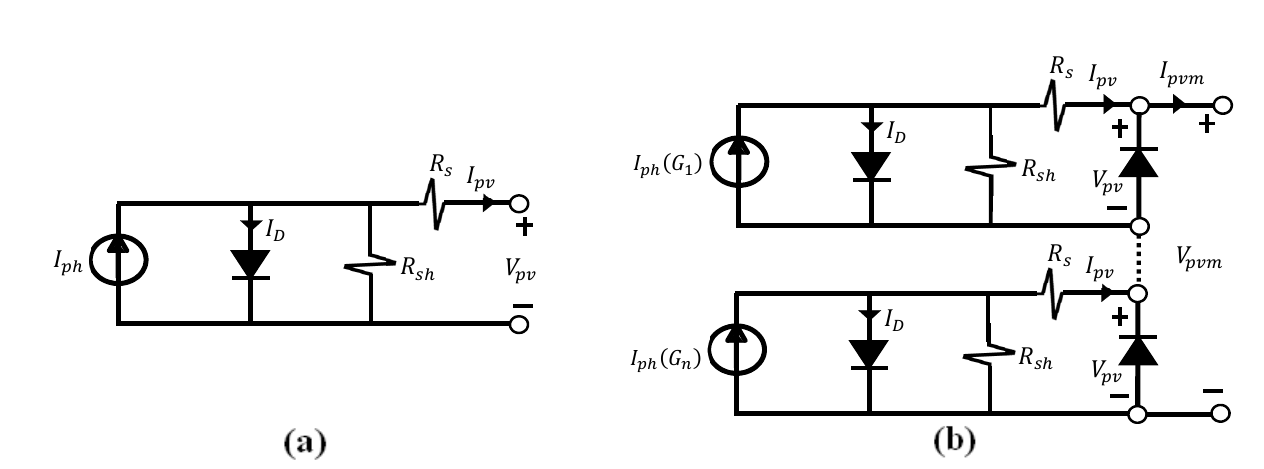
Figure 3. The equivalent circuit of the PV cells: ( a ) under (UI); ( b ) under (PSC). Applying Kirchhoff’s Current Law for the PV cell equivalent circuit, then, the mathe- matical equation of the PV cell output current can be represented by